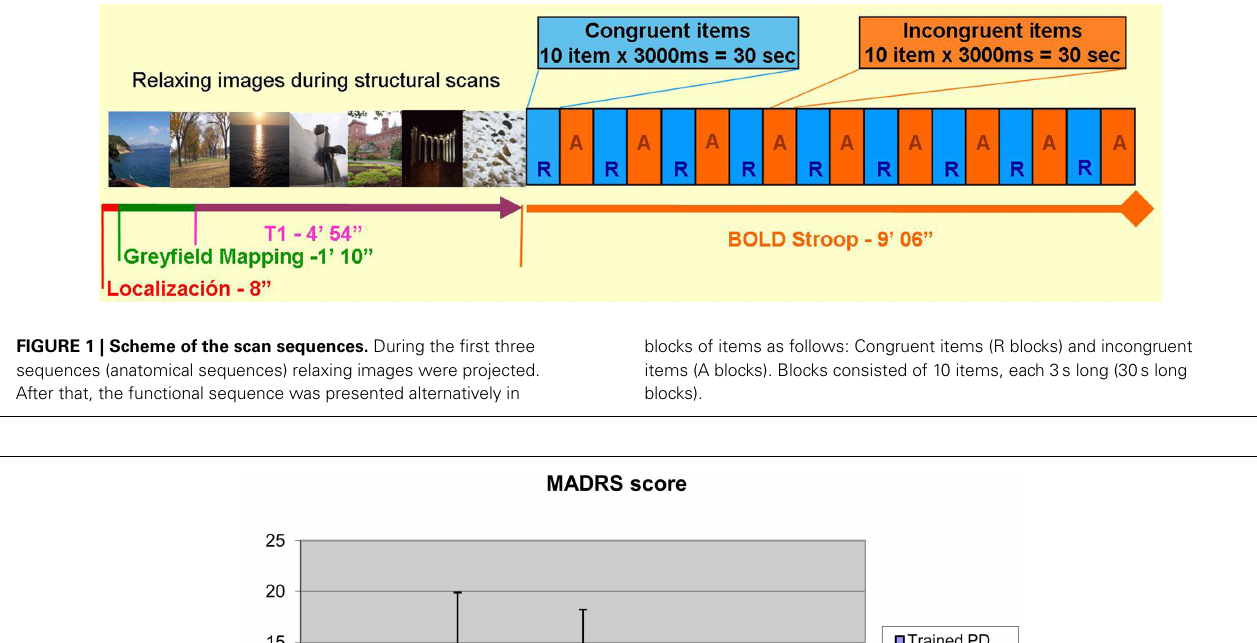
Table 1 ). With respect to the Sudoku puzzles, PD patients